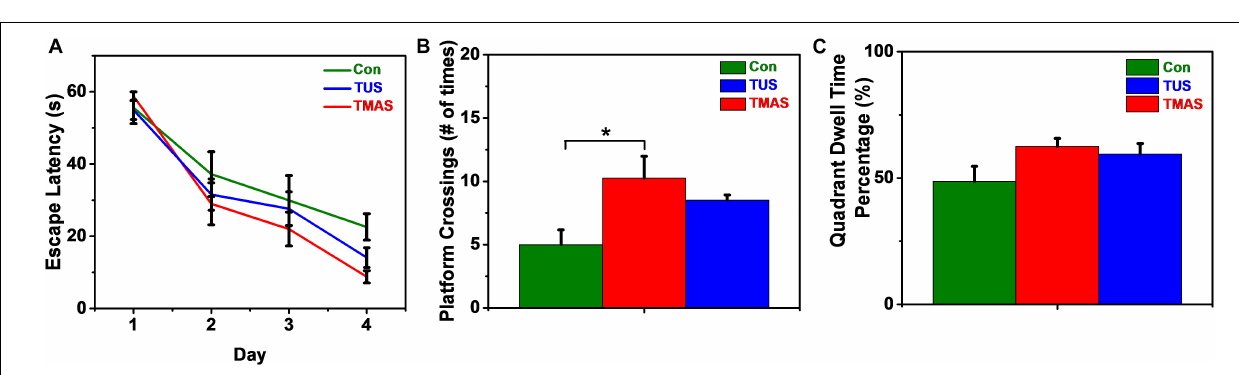
recording, compared with 74.4 ± 1.4% in the Con group. We quantified the extent of LTP and DP by calculating the averages of the last 10 min of LTP recording or DP recording for each group of mice, as illustrated in Figure 12 . For the LTP results